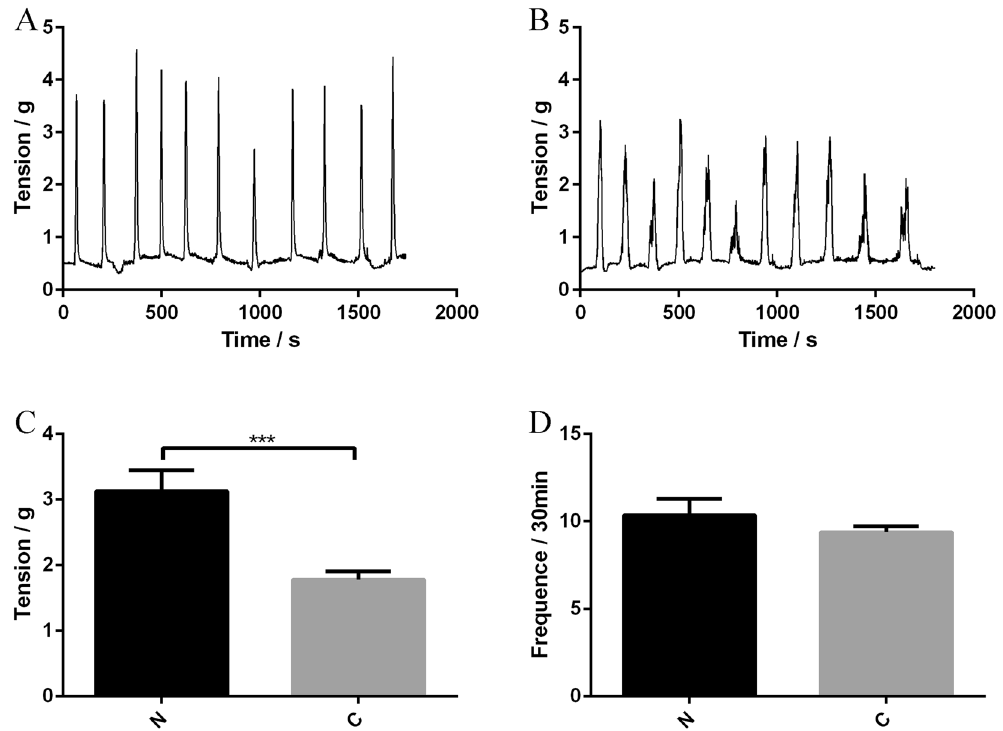
Figure 4. Transplantation of fecal microbiota from STC donors regulates colonic contractility (Group N = 6, Group S = 12). Recordings were made of spontaneous phasic contractions of proximal colon. Representative recordings from mice receiving fecal microbiota of healthy donors ( A ) and mice receiving fecal microbiota of STC donors ( B ). Tension ( C ) and frequency ( D ) normalized to basal values in mice receiving fecal microbiota from healthy and STC donors. Data represent the mean ± SEM. *** p < 0.001. Group N: mice receiving fecal microbiota from healthy donor; Group C: mice receiving fecal microbiota from STC donors. STC: slow transit